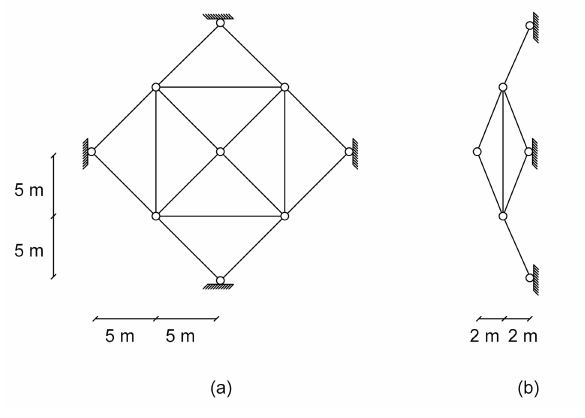
Figure 9: Geometry of the sixteen-member lattice structure: (a) top view; (b) lateral view